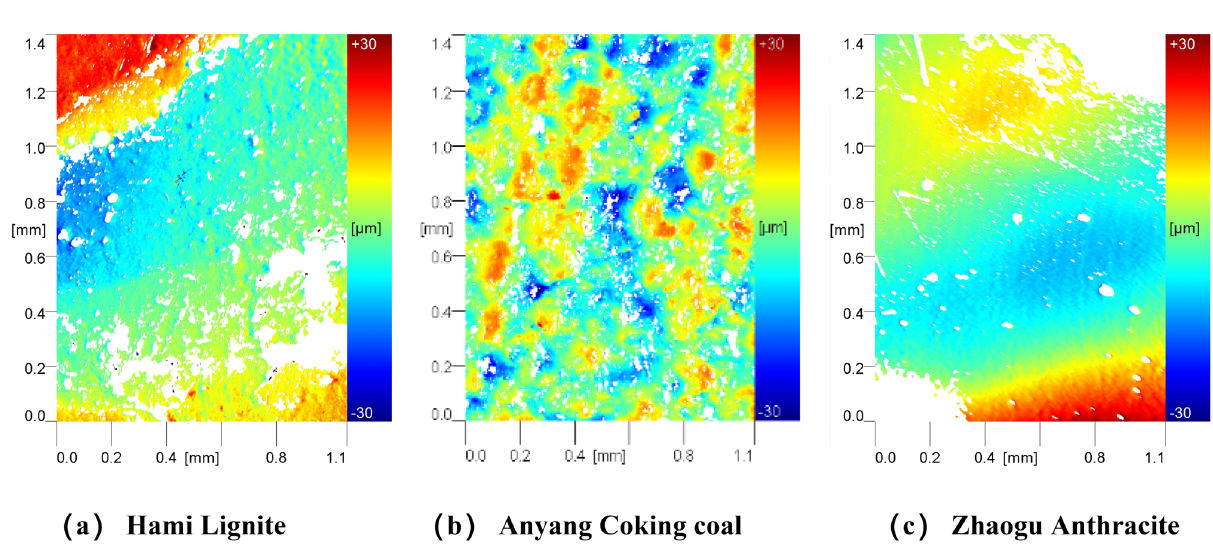
Figure 3. 2D reconstructed topography images of the three coal